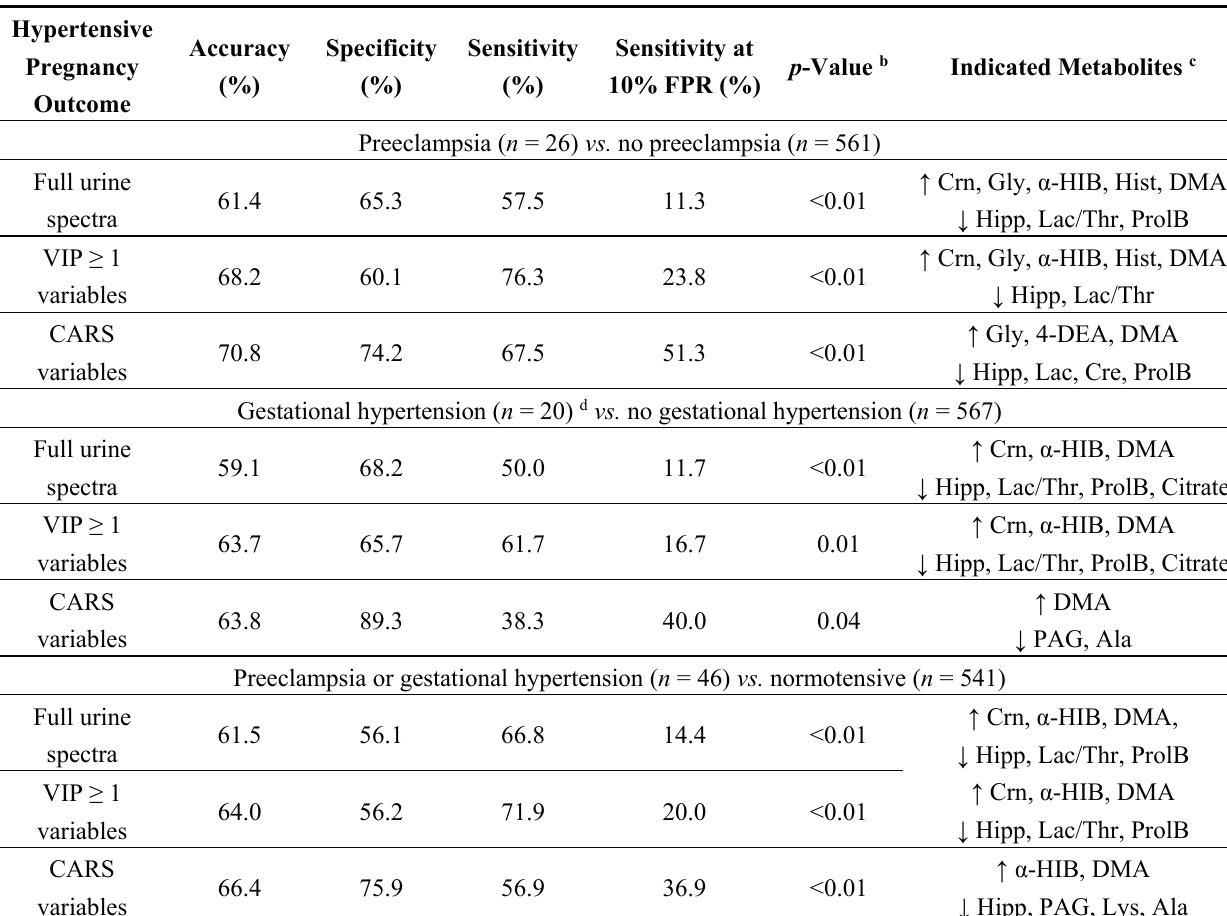
Table 2. Urine metabolite multivariate models predicting preeclampsia and/or gestational hypertension a .